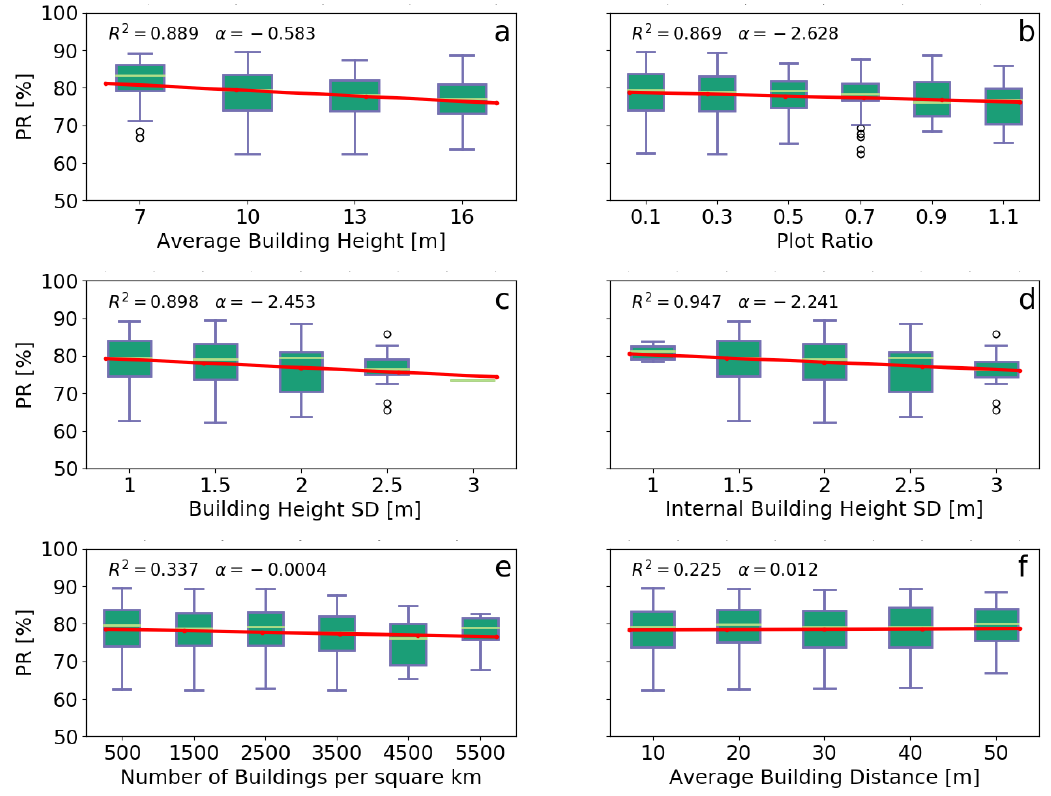
Figure 8. Comparison of the average PR using linear regression with ( a ) ABH; ( b ) plot ratio; ( c ) BHSD; ( d ) IBHSD; ( e ) number of buildings per km 2 ; ( f )